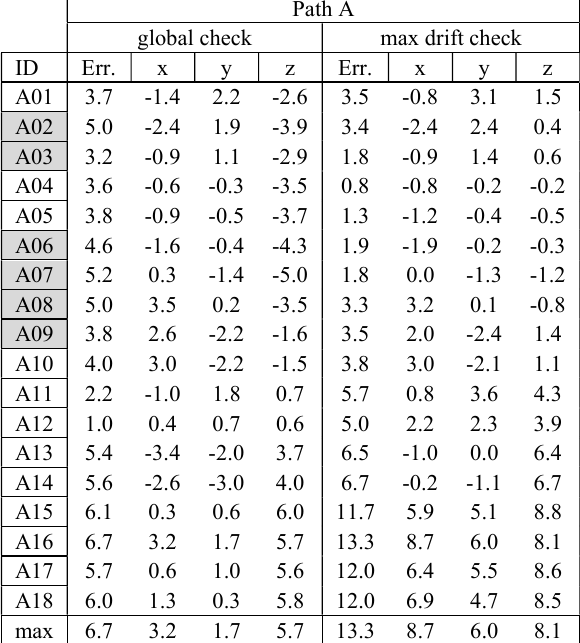
Table 2. Error check of Path A. For “global check” all points are used as CPs, while for “max drift check” points highlighted in grey (white in Figure 6) are used as GCPs in a similarity transformation. All errors are expressed in